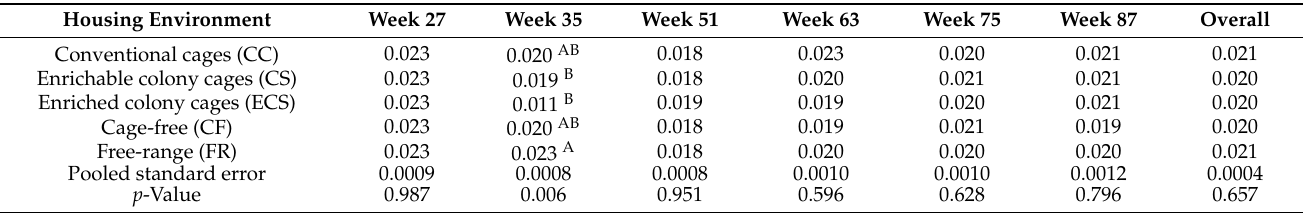
housing environments for vitelline membrane elasticity during any timepoint or overall. Table 10. The effect of housing environment on vitelline membrane strength (N/mm) of brown egg layers by week and overall.